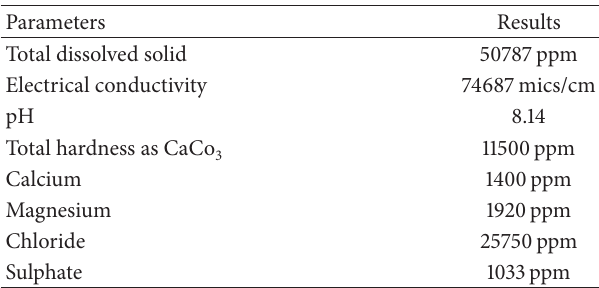
Table 1: Physicoparameters of sea water (Ramnad, Tamil Nadu,